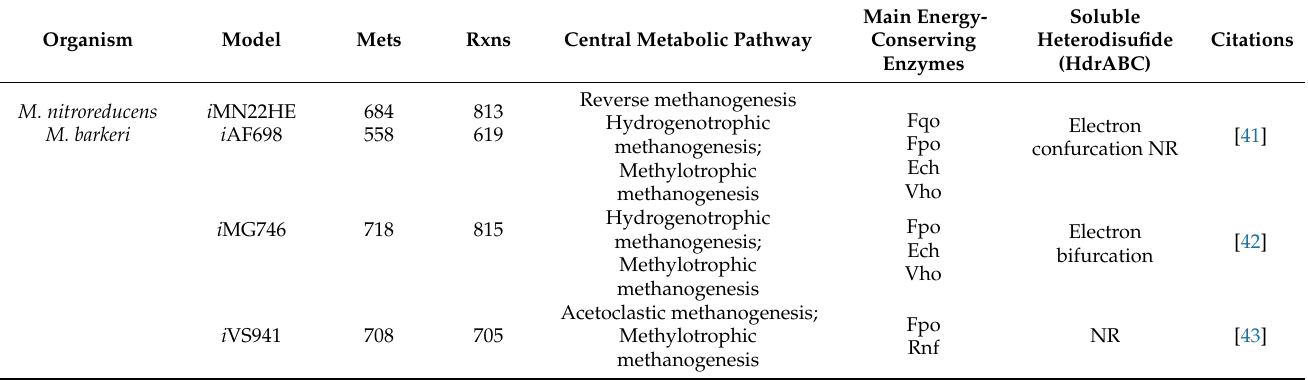
Table 1. Properties comparison of i MN22HE with related methanogen metabolic